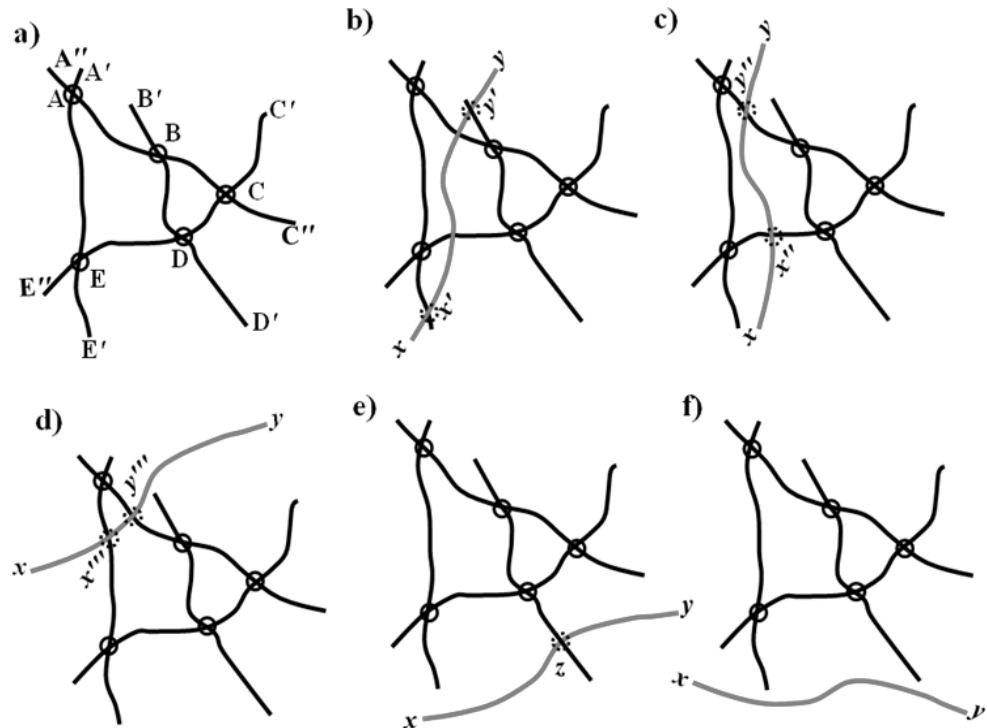
Figure 8. Schematic illustration of the backbone structure variation mechanisms in the CNF infinite cluster with the addition of CNF above the percolation threshold: ( a ) original infinite cluster; ( b ) the increased CNF locates on the loop and the connected part of the previous dangling ends; ( c , d ) the increased CNF locates on the loop, but does not connect any previous dangling ends; ( e ) the increased CNF belongs to the infinite cluster, but neither locates on the loop nor connects any previous dangling ends; ( f ) the increased CNF is isolated and does not belong to the infinite cluster